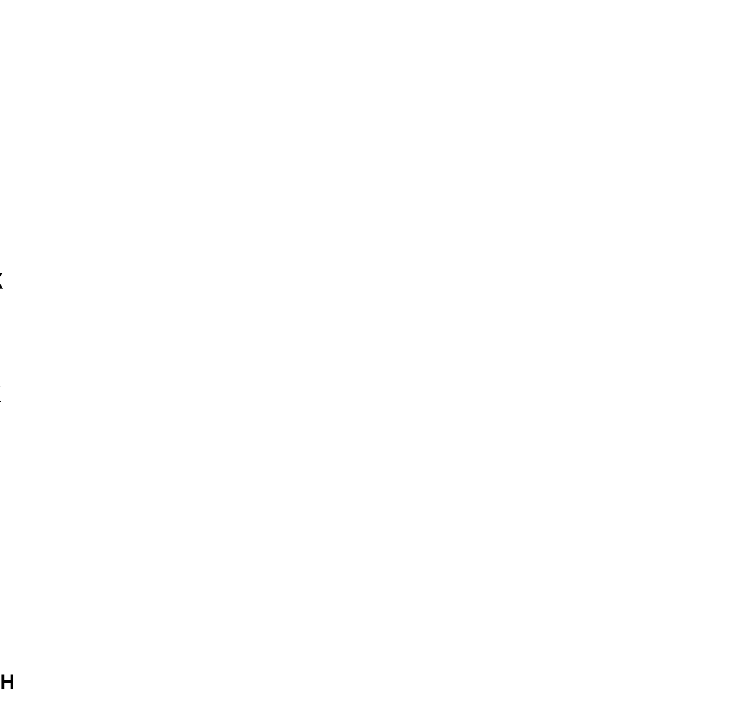
Figure 9. Effect of PAOX expression on phosphorylation of signaling proteins involved in activator protein-1 (AP-1) and nuclear factor kappa-light-chain-enhancer of activated B cells (NF- κ B) pathways in fibroblasts. Fibroblasts infected with vector or PAOX viruses were incubated in a serum-free DMEM for 6 h. The protein levels of I κ B α and the phosphorylation levels of extracellular signal-regulated kinase (ERK), c -Jun N -terminal kinase (JNK), p38 mitogen-activated protein kinase (MAPK), and NF- κ B were assessed using Western blot analysis.